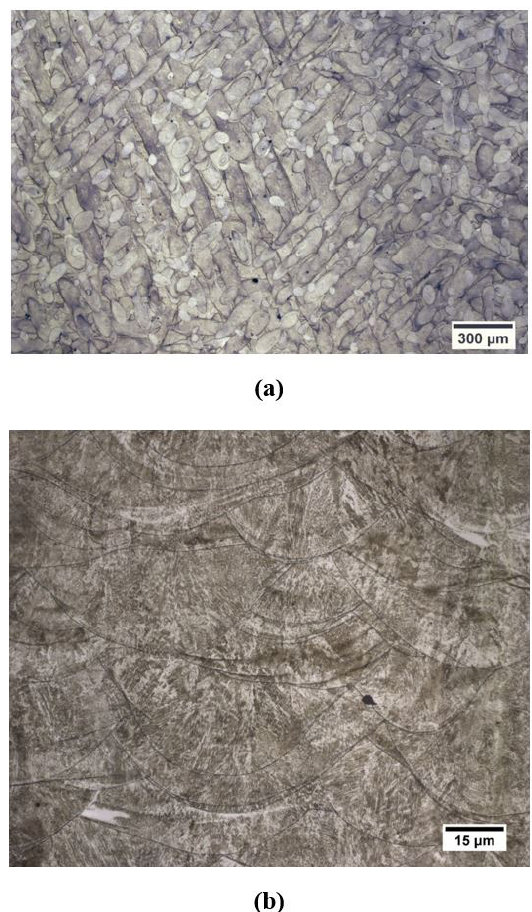
Figure 13. Micrography obtained by optical micrography of the maraging 300 steel produced by additive manufacturing 67 : a) top view, etched with nital 2%, b) side view, after two etchings: nital 2% and automatic polishing with the solution: 10 mL colloidal silica + 2 mL distilled water + 0.2 g ammonium